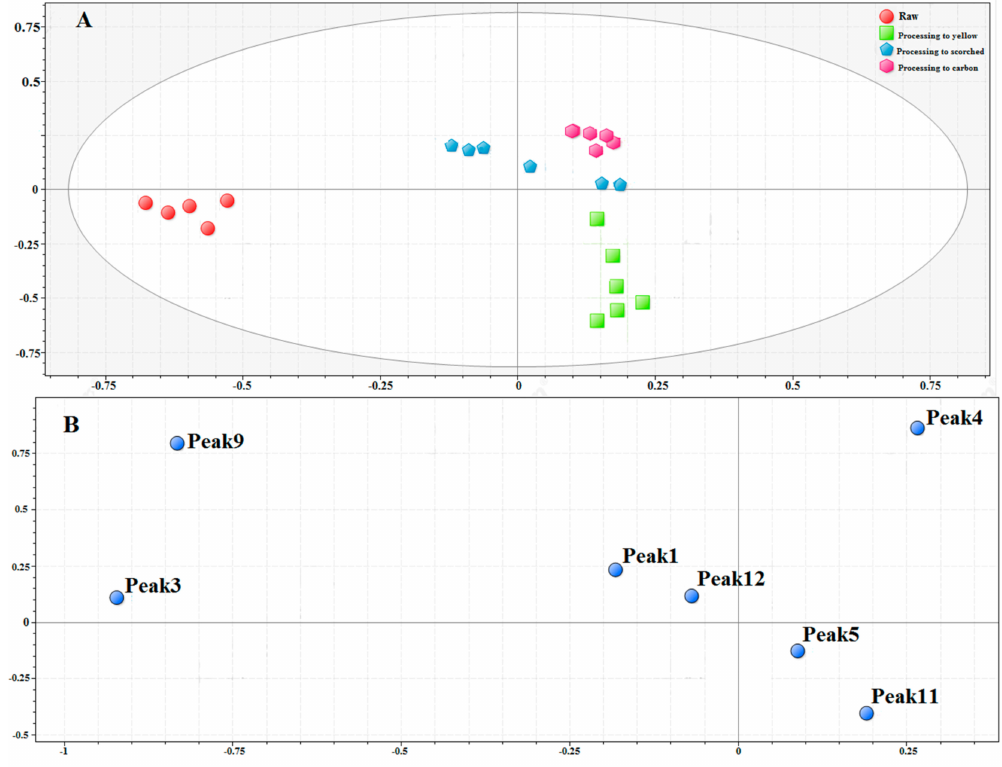
Figure 5. ( A ) PCA scores plot; and ( B ) loading plot for raw pieces and different processed